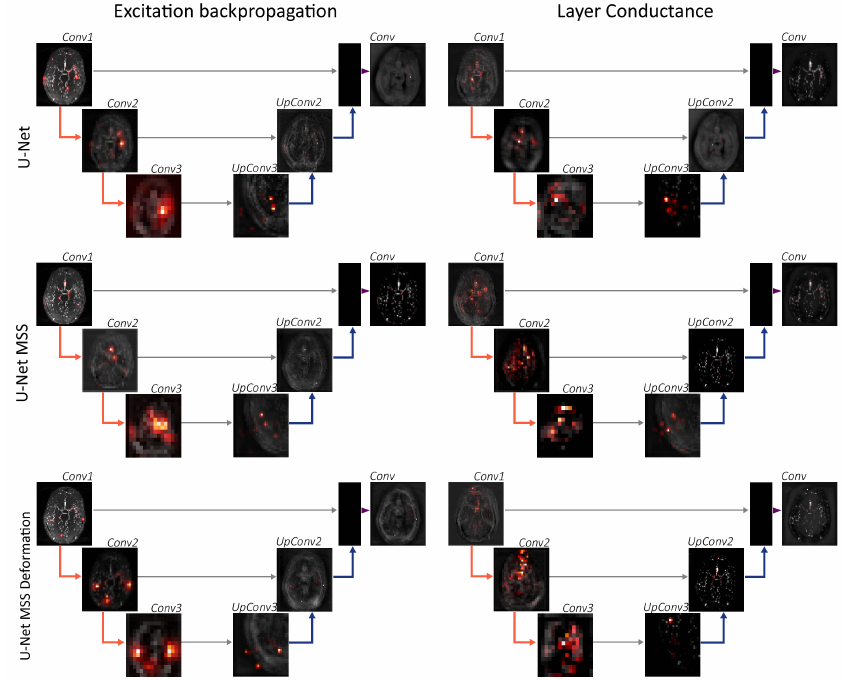
Figure 7. Layer-based interpretability methods: Excitation Backpropagation and Layer Conductance, shown using representative U-Nets. The higher the intensity of red, the higher the concentration of the focus of the network. This figure shows how the focus of the network changes in each layer for the three different models.